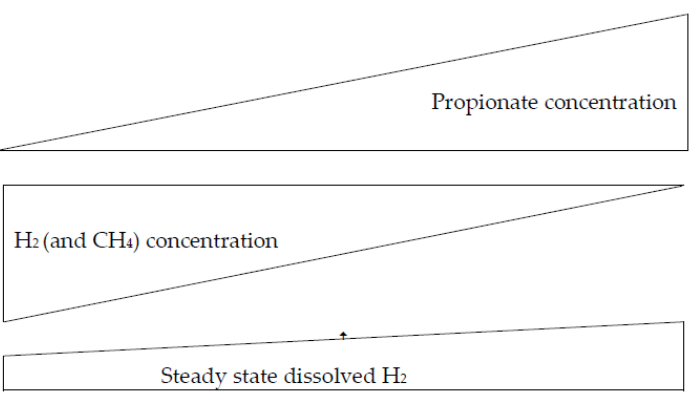
Figure 1. Relationship between H 2 , CH 4 , and propionate concentrations, according to Janssen [18].